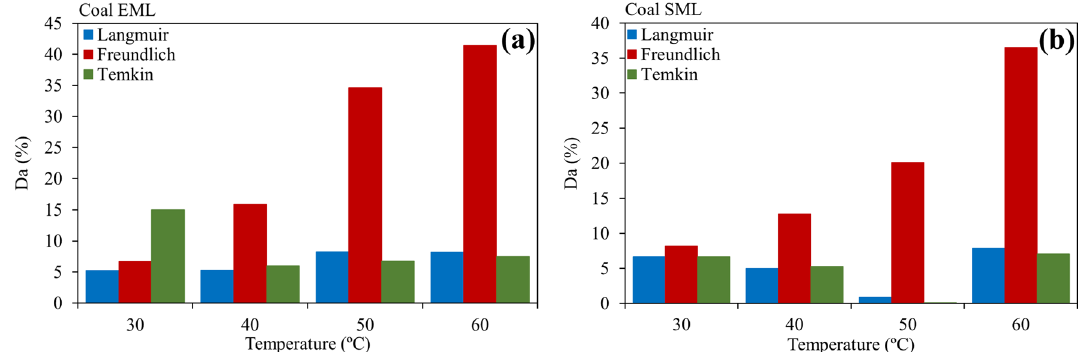
Fig. 7 Statistical comparison of experimental and theoretical maximum CO 50 ºC, and 60